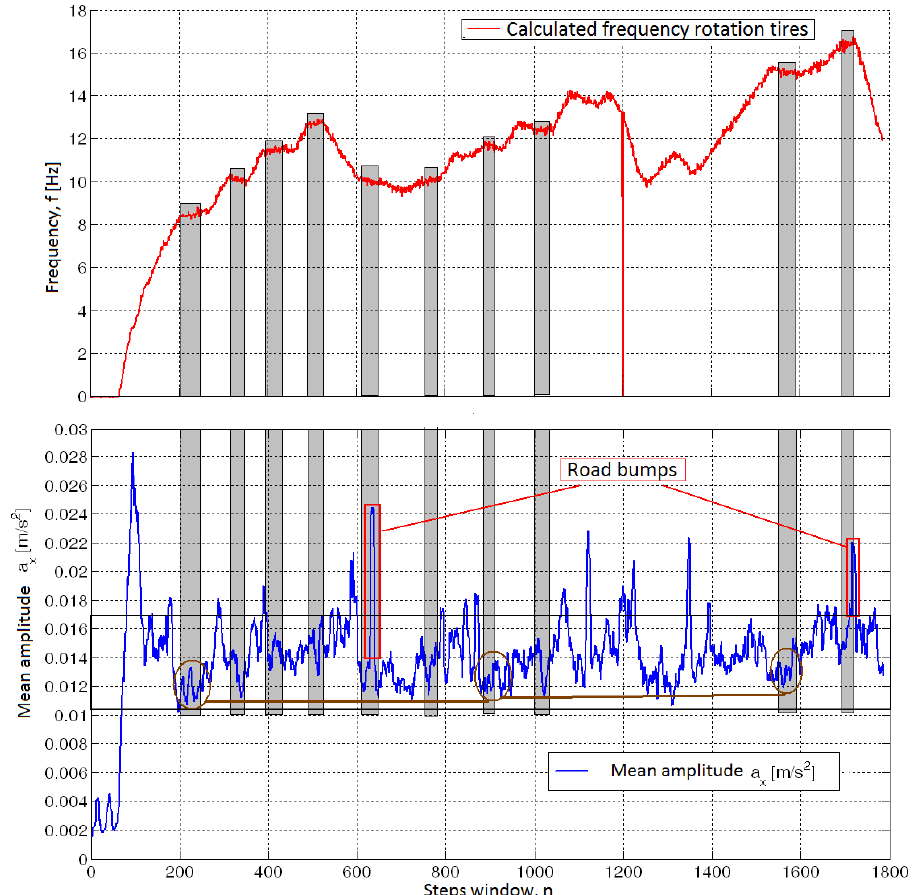
Figure 13. Mean value of signal for longitudinal axis (x-axis). Grey boxes point distances with the constant speed.